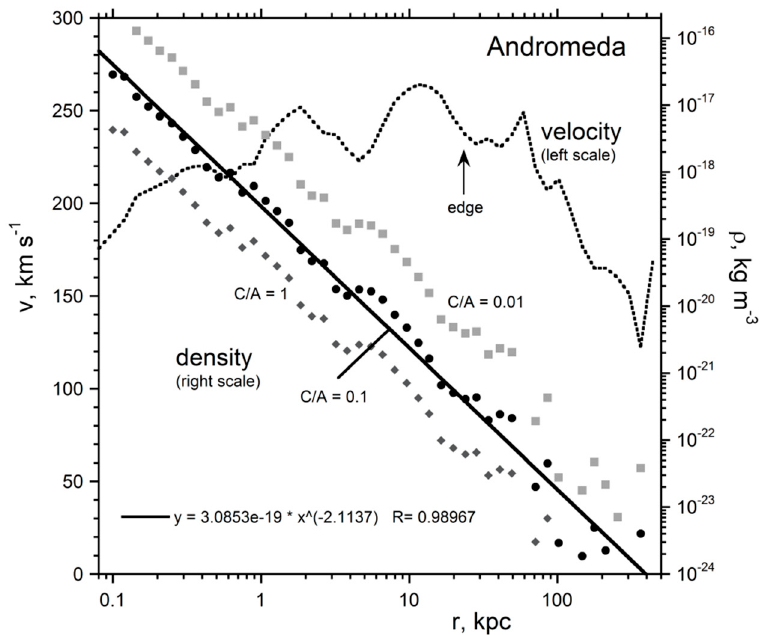
Figure 3. Velocity curve (dotted line, left scale) for Andromeda (RC from [34]), and the corresponding density profiles (right scale) calculated by the inverse model of Equation (10). The effect of shape is illustrated for three choices of the C/A ratio, 1 (diamonds), 0.1 (dots), or 0.01 (squares). Densities in Andromeda span at least 7 orders of magnitude, but vary regularly, approximately conforming to a power law with n ~ 2. Please note that much mass lies beyond the visual edge, whose radial position is shown by the vertical arrow.